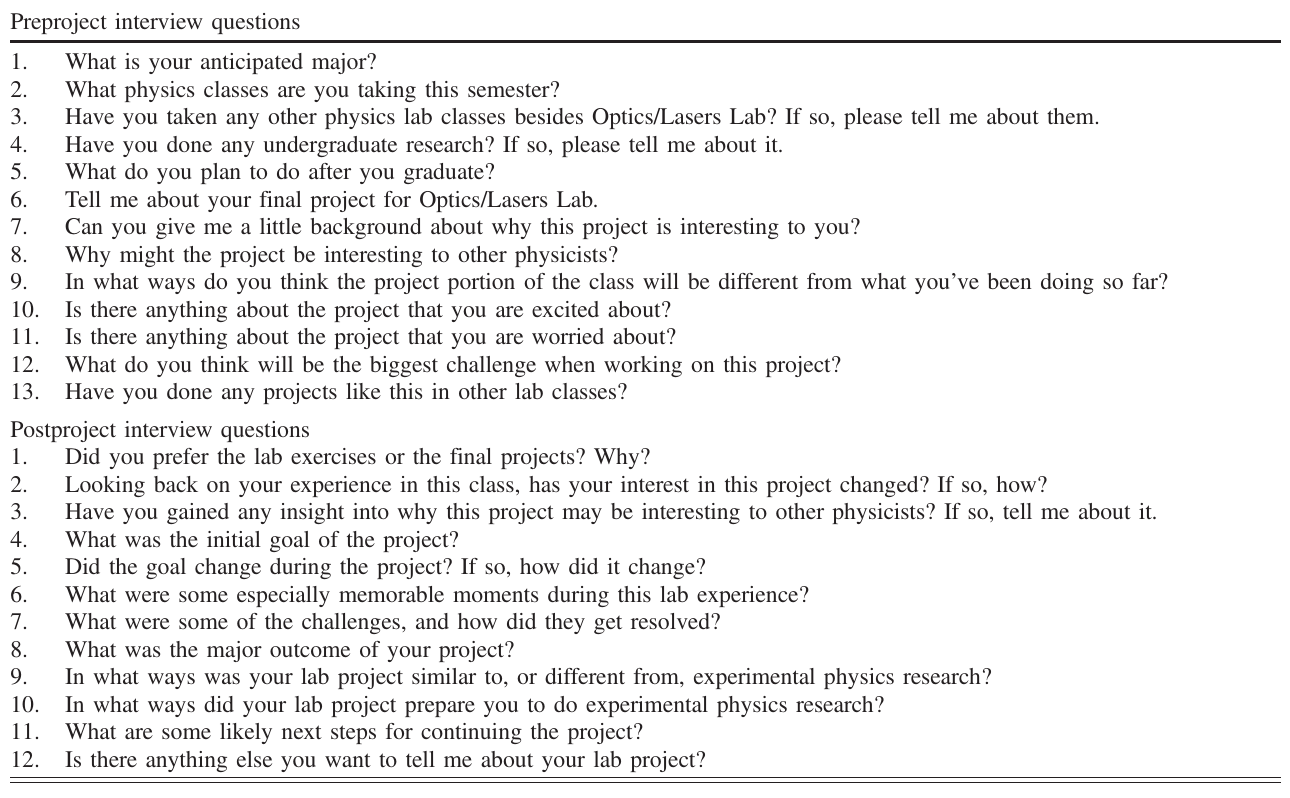
TABLE II. Pre- and postproject interviews questions, in the order they were asked during each